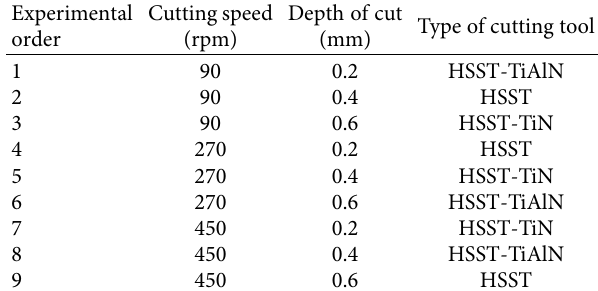
9 Orthogonal array for fitting the input process